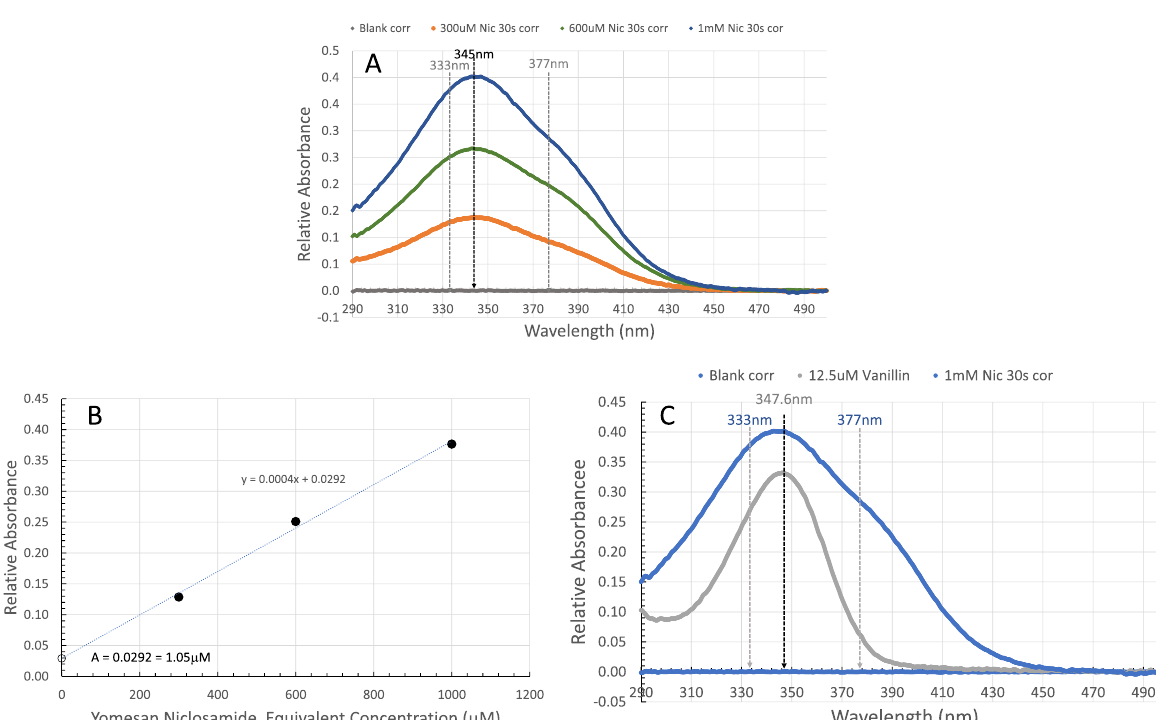
Fig. 2 Comparison between baseline-corrected UV-Vis spectra for Yomesan at the 30 s time point for initial Yomesan niclosamide-equivalent concentrations of 300 µM, 600 µM, and 1 mM in pH 9.35 Tris buffer. A UV-Vis spectra showing the “impurity” peak indicated (black arrow) at 345 nm, and the expected double niclosamide peaks indicated (gray arrows) at 333 and 377 nm. B Relative absorbance at 333 nm vs. initial added Yomesan niclosamide-equivalent concentration (µM) reveals a linear dependence to the “impurity” absorbance with an intercept at an Absorbance of 0.0292 AU, which would be equivalent to a niclosamide concentration of 1.05 µM. C Comparison between the UV-Vis spectra for the 30s “impurity” for 1 mM Yomesan niclosamide and a 12.5 µM vanillin solution, both in pH 9.35 Tris